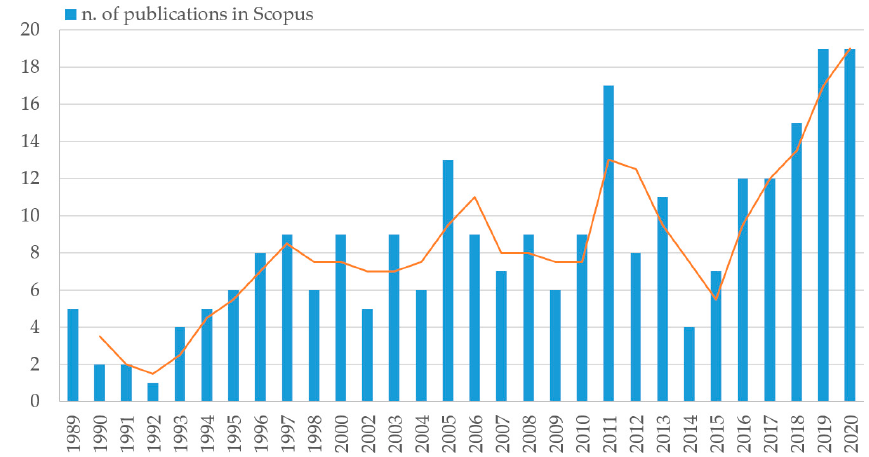
Figure 3. Annual Scientific Production.